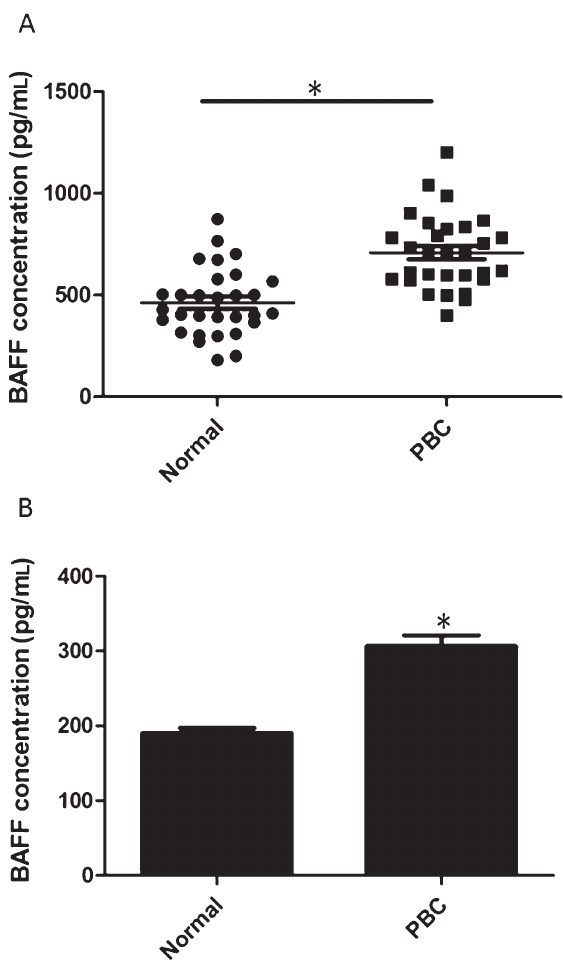
Figure 2. B-cell-activating factor (BAFF) expression in peripheral blood and isolated B cells from healthy donors and primary biliary cirrhosis (PBC) patients. A , Sera were obtained from blood collected from 30 PBC patients (mean ± SE = 708.4 ± 33.2) and 30 healthy donors (mean ± SE = 462.1 ± 30.05) and assessed with a BAFF ELISA kit. B , B cells were isolated using CD19 MicroBeads and isolated B cells were cultured with RPMI 1640 medium supplemented with 10% FBS. The supernatant of isolated B cells was collected and assessed with a BAFF ELISA kit. Data are reported as means ± SE from 30 different donors. *P , 0.05 vs normal (two-tailed Student t